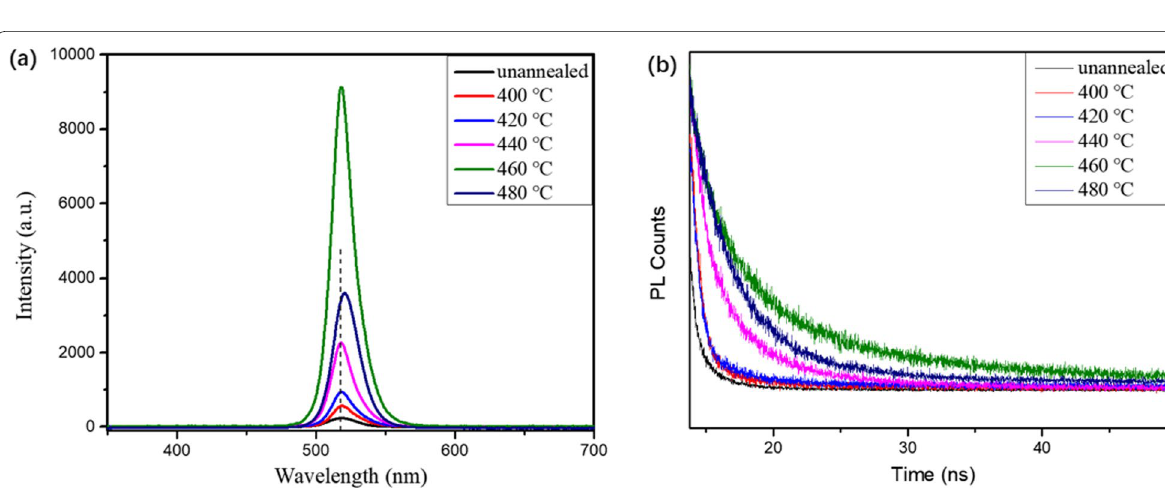
Fig. 7 a PL spectrum, b time-resolved PL decay curves of CsPbBr 3 thin films annealed at different